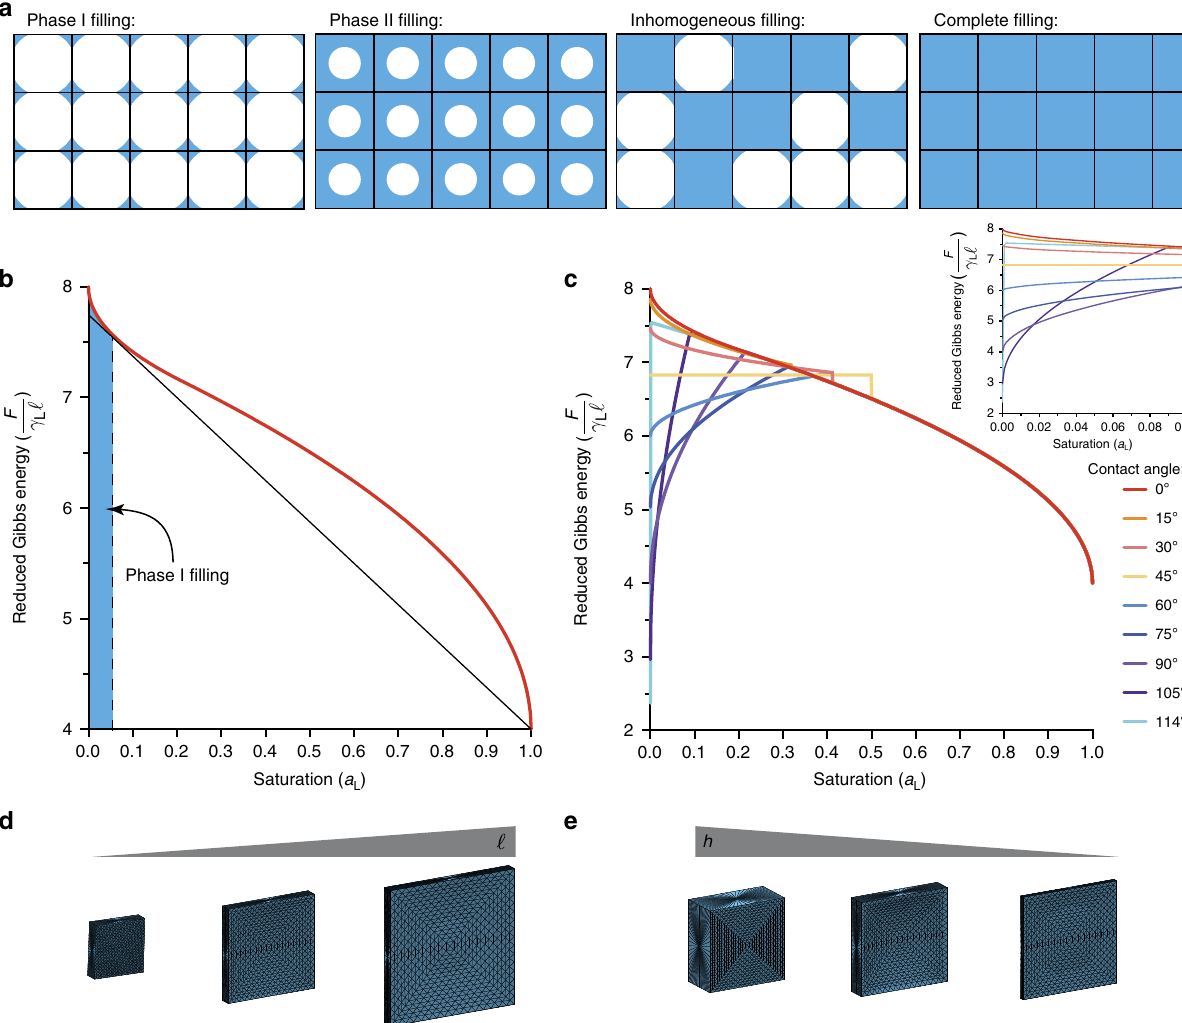
Fig. 3 Suspended liquid fi lm formation. a Phases of fi lling of a two-dimensional, square-cell mesh with increased liquid saturation. As described, phase II fi lling is not observed physically. b Plot of the reduced Gibbs energy as a function of saturation for θ = 0°. c Plot of the reduced Gibbs energy as a function of saturation for θ = 0°, 15°, 30°, 45°, 60°, 75°, 90°, 105°, and 114°. Inset graph for α L = [0, 0.1]. d Surface Evolver simulations of suspended liquid fi lms with varying window lengths l . e Surface Evolver simulations of suspended liquid fi lms with varying pipe diameters